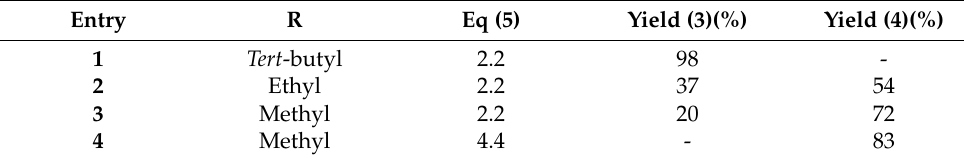
Table 1. Different R groups and their yields.